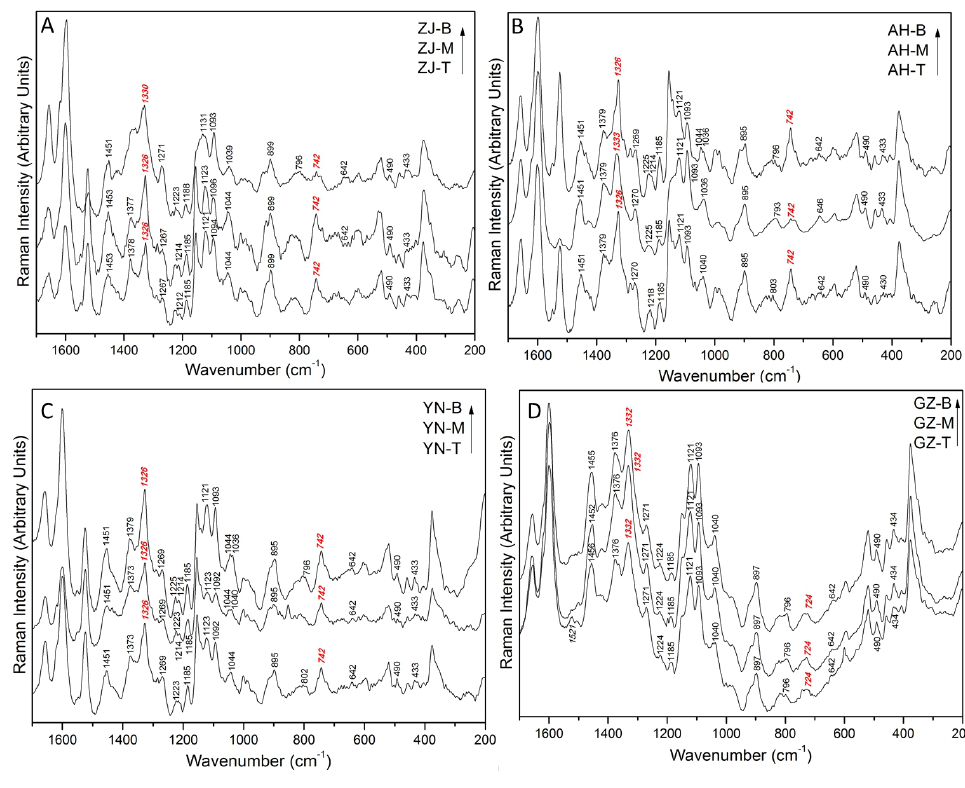
Figure 3 Raman spectra of Dendrobium candidum/officinale (ZJ/AH/YN) and nobile (GZ) at different positions (B-bottom, M-middle, T-top). ZJ, AH, YN and GZ represent the origin of Dendrobium in (A) Zhe-jiang, (B) An-hui, (C) Yun-nan and (D) Gui-zhou, respectively. Full-size DOI: